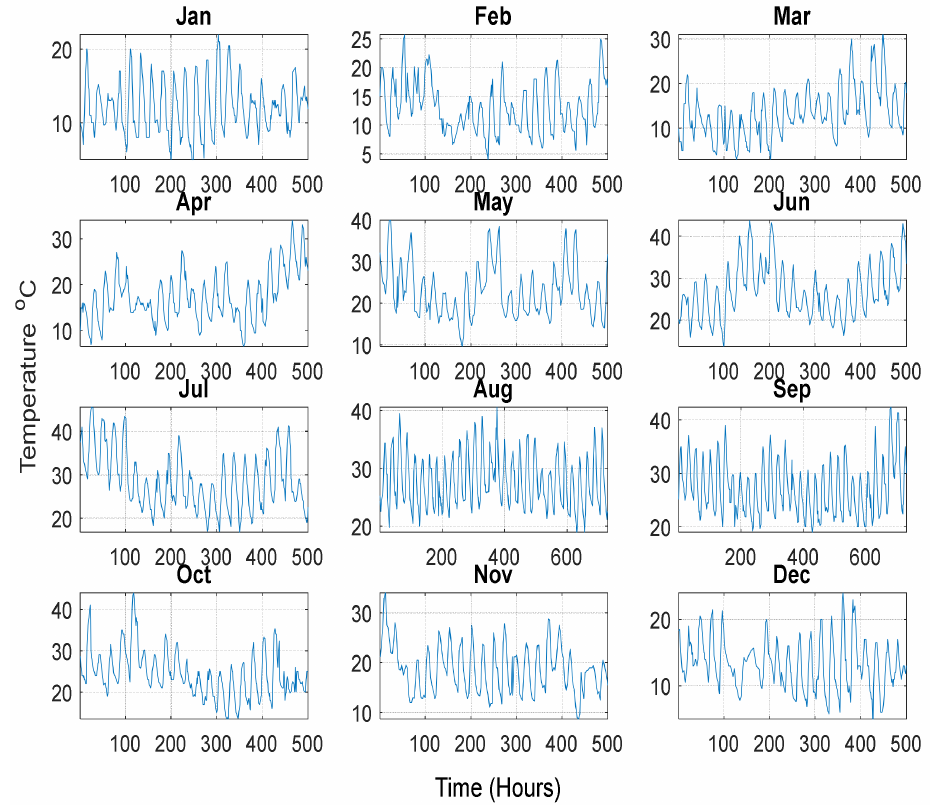
Figure 4. Monthly ambient temperature data for the case